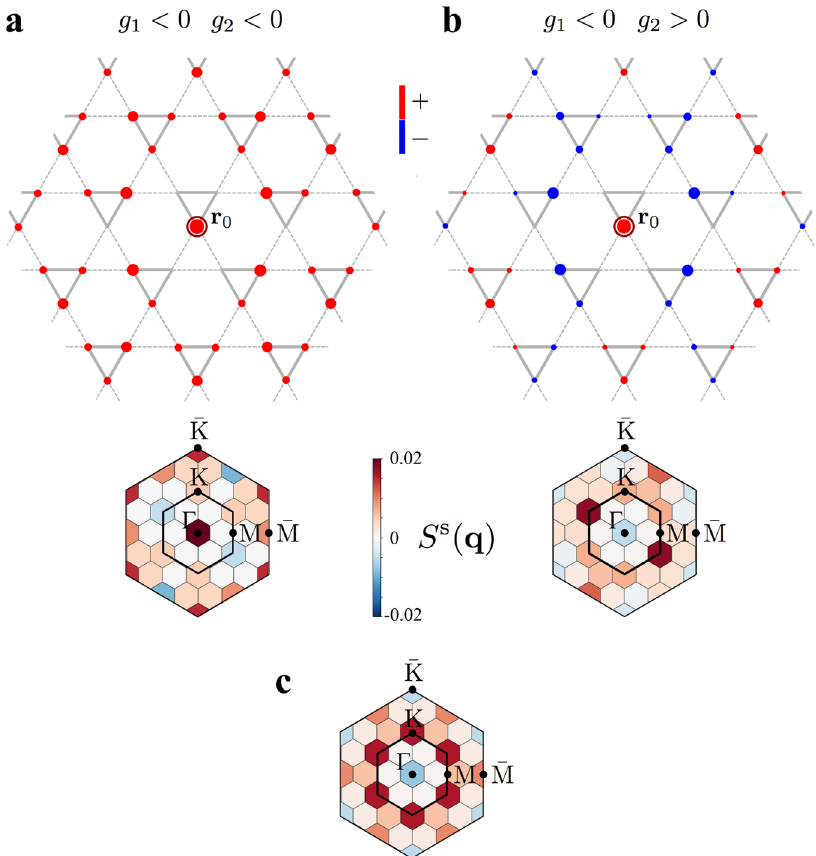
Fig. 5 Spin – spin correlation functions of the quantum dimer model. Spin – spin correlation functions (with respect to the central site r 0 ) and the corresponding static structure factors on the extended Brillouin zone of the quantum dimer model H ⎔ with a g 1 = − 0.01, g 2 = − 0.01 and b g 1 = − 0.02, g 2 = 0.01. The radius of the dots is proportional to the absolute value of the correlation function, and the colour encodes the sign (red for a positive value, blue for a negative value). c Static structure factor of H D calculated for the kagomé unit cell with three sites and the model parameters derived for LiZn 2 Mo 3 O 8 .